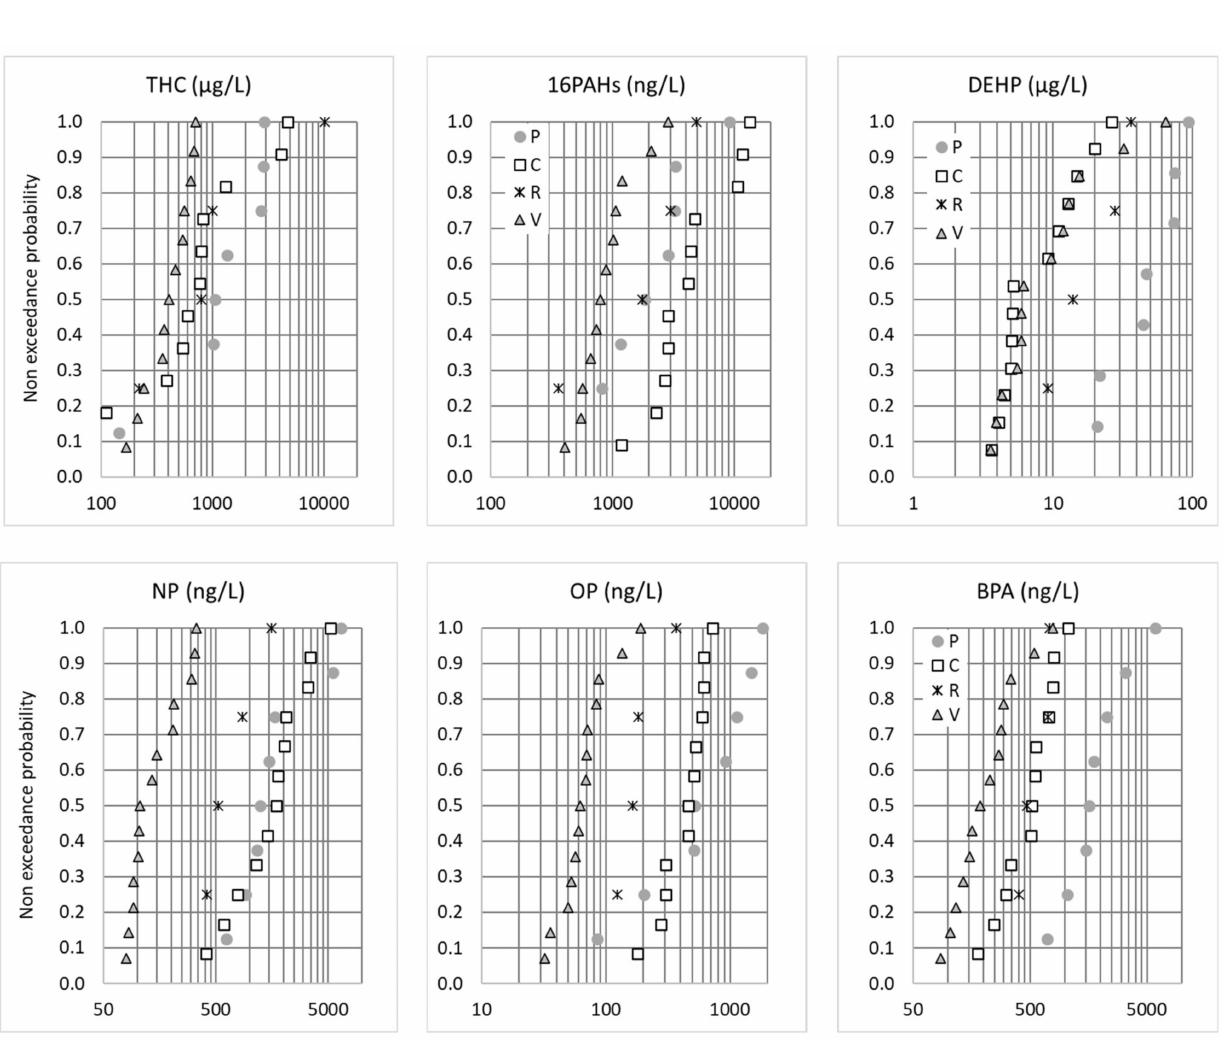
Figure 4. Non-exceedance probability distributions of the total EMCs ( µ g or ng/L) for THC, 16PAHs, DEHP, BPA, NP and OP. P = Paris, C = Compans, R = Rosny-sous-Bois and V =